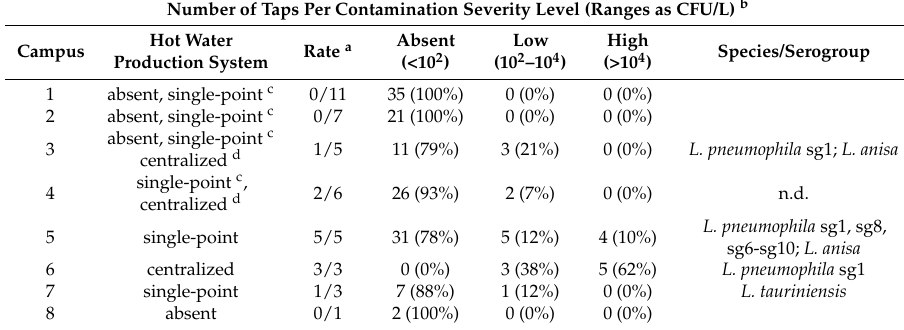
Table 1. Rate of Legionella contamination in the building plumbing system of University campuses. Number of Taps Per Contamination Severity Level (Ranges as CFU/L)